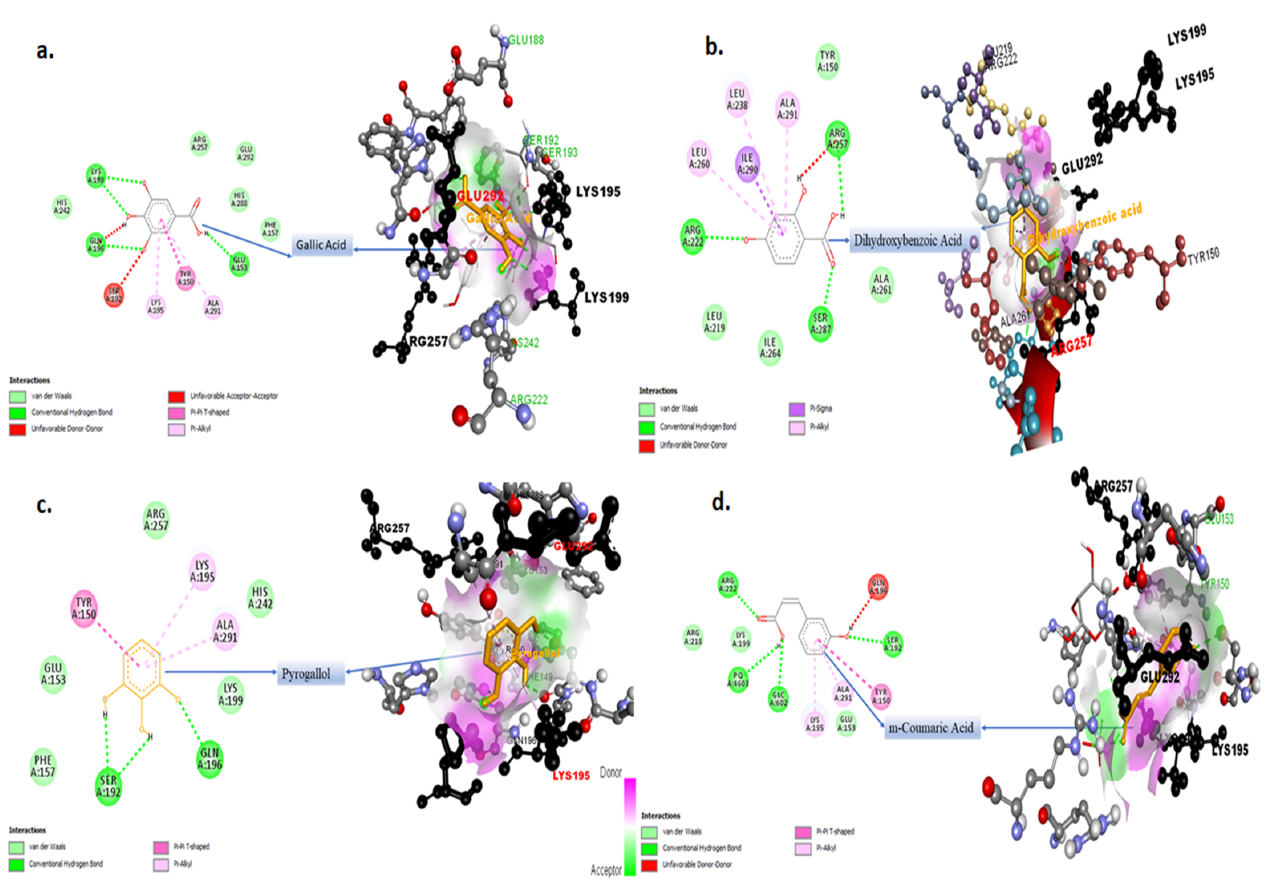
Figure 10. 2D and 3D interaction models of ligands with HSA. Ligands used are ( a ) gallic acid, ( b ) dihydroxy benzoic acid, ( c ) pyrogallol, and ( d ) m-coumaric acid. Table 3. Ligands. Common name refers to the compound name used in the study.